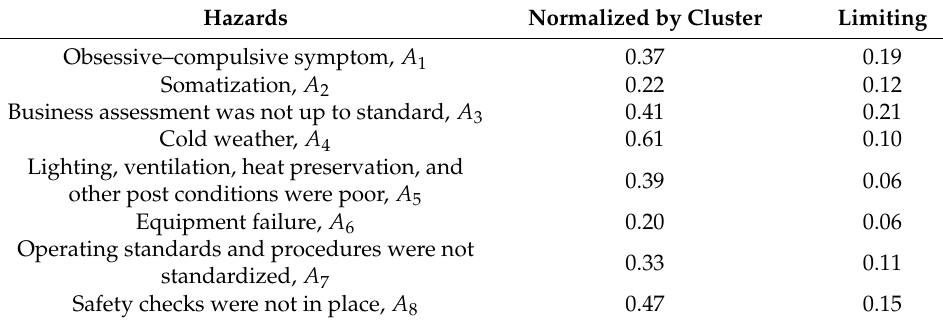
Table 12. Weight value of hazard factor in grid G H .